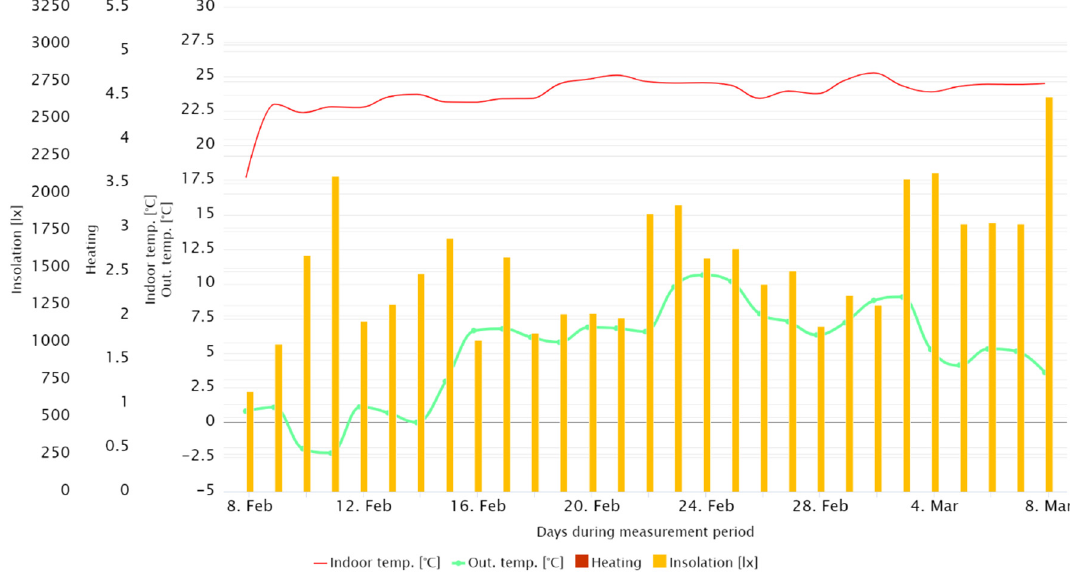
Figure 9. Daily averages of the internal temperature for room 104 referring to heating valve position, insolation, and outdoor temperature.